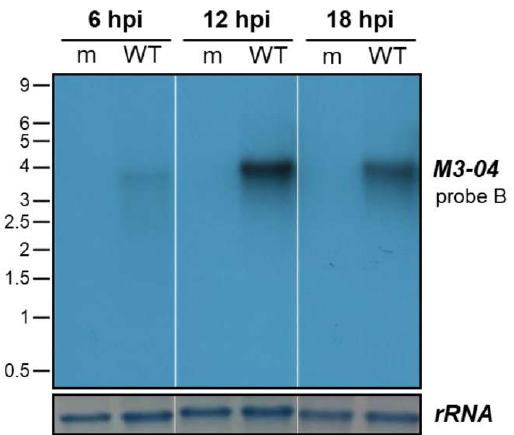
Figure 3. Timecourse of M3-04 expression. NIH 3T12 fibroblasts were mock-infected (m) or infected with wild-type MHV68 (WT) at MOI 5. At 6, 12, and 18 hpi, total RNA was harvested and northern blot analysis was performed using probe B to detect M3-04 transcript. 18S rRNA on the methylene blue stained membrane is shown as the loading control.